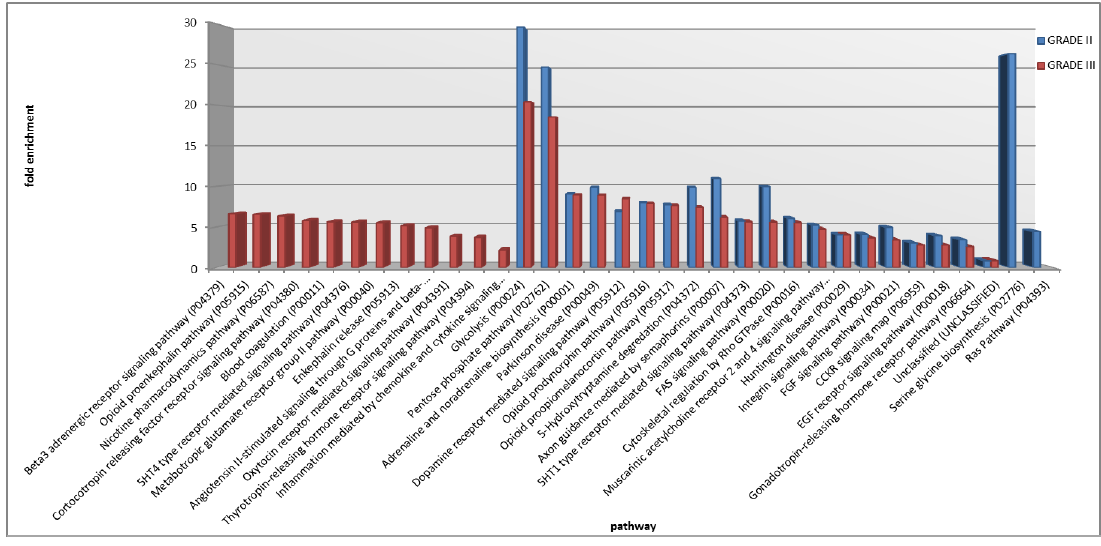
Figure 9. Pathways overrepresentation analysis of WHO grade II and grade III PF-EPs common protein lists.